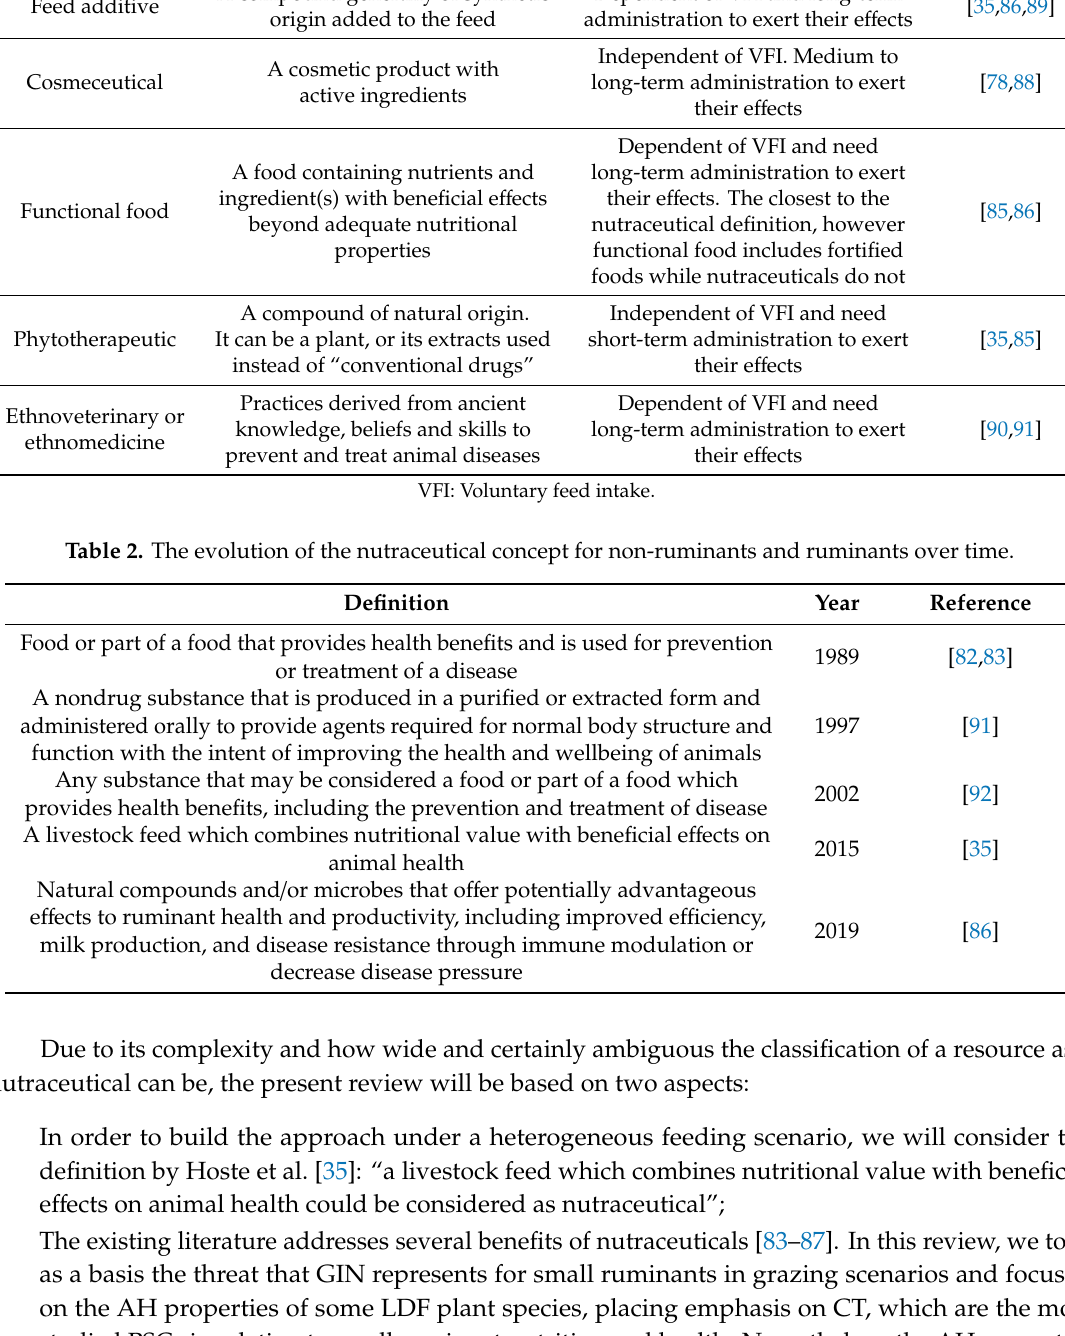
Table 1. Definitions related to feed characteristics commonly associated to the nutraceutical concept. Concept